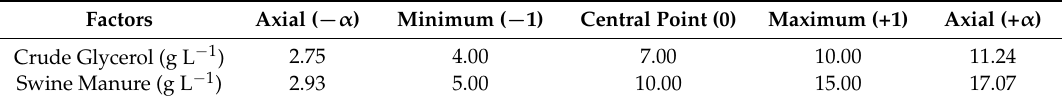
Table 7. Matrix of the central composite design containing four axial points and four central points, used to study the hydrogen production of CG with SM. Factors Axial ( − α ) Minimum ( −